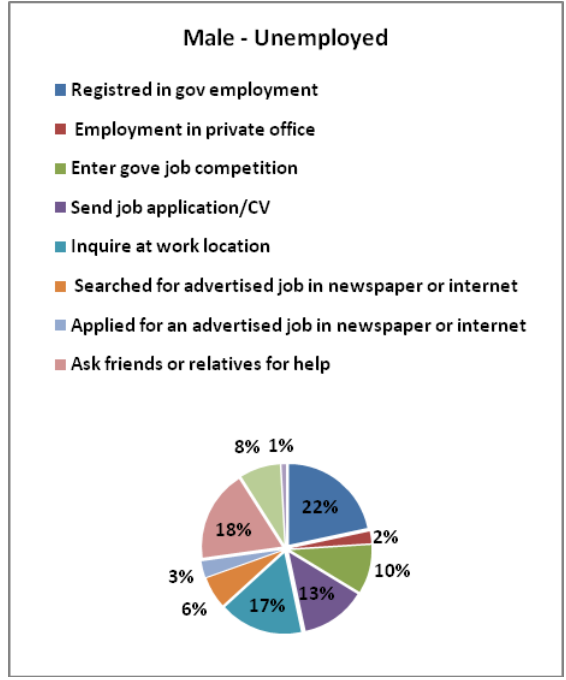
Figure 14: Job search methods of unemployed youth by gender